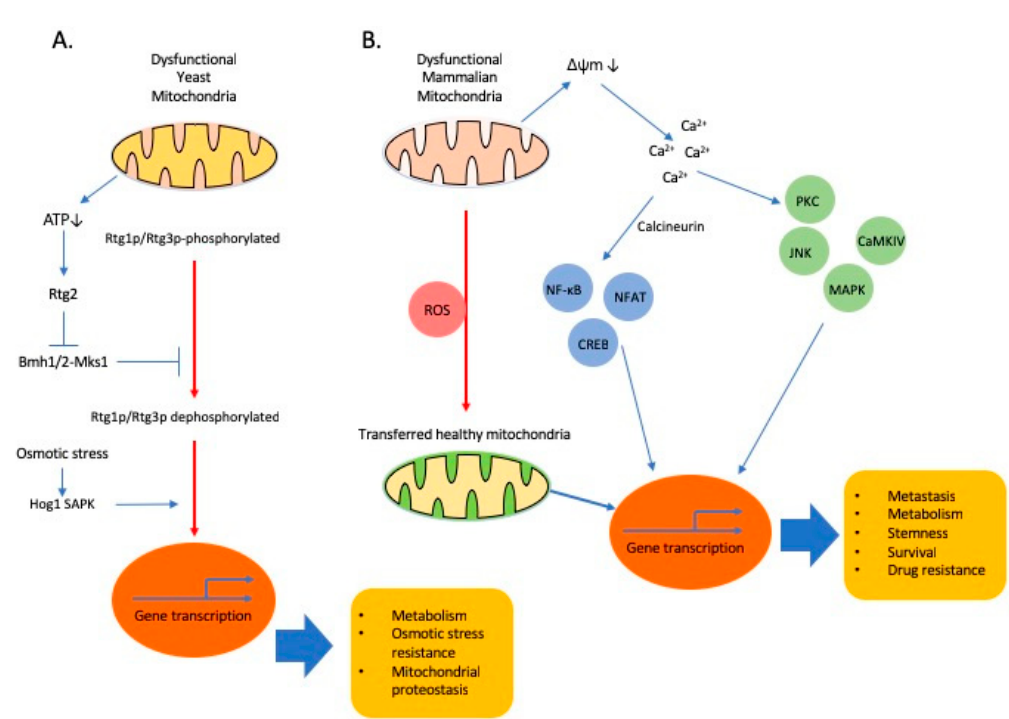
Figure 1. Retrograde signalling and cellular adaptations. ( A ). In yeast, Rtg dependent signalling is the first found major pathway through which mitochondria communicates with nucleus. Rtg1p and Rtg3p are basic helix-loop-helix/leucine zipper (bHLH/LeuZip) transcription factors and nuclear translocation of Rtg1/3p is dependent on partial dephosphorylation of Rtg3p. Rtg2 promotes the dephosphorylation of Rtg3p and its nuclear translocation [37]. Osmotic stress activates Hog1 SAPK. Hog1 SAPK binds to the Rtg1/3p transcription factor and allows its translocation to the nucleus [38]. ( B ). Mitochondrial dysfunction, such as mitochondrial DNA (mtDNA) depletion or OXPHOS inhibition, triggers mitochondrial retrograde signalling in mammalian cells. For example, mitochondrial stress can activate a Ca 2+ -dependent retrograde signalling that is comprised of two branches: one mediated by calcineurin for the nuclear translocation of NF- κ B or CREB or NFAT and the other directly dependent on activation of Ca 2+ -dependent protein kinases, such as PKC, JNK, MAPK and CAMKIV. Horizontal transfer of healthy mitochondria from stromal cells in the TME can restore mitochondrial functions and is suggested to participate in the retrograde signalling. Emerging evidences show that ROS stimulates horizontal transfer of mitochondria [39,40] .